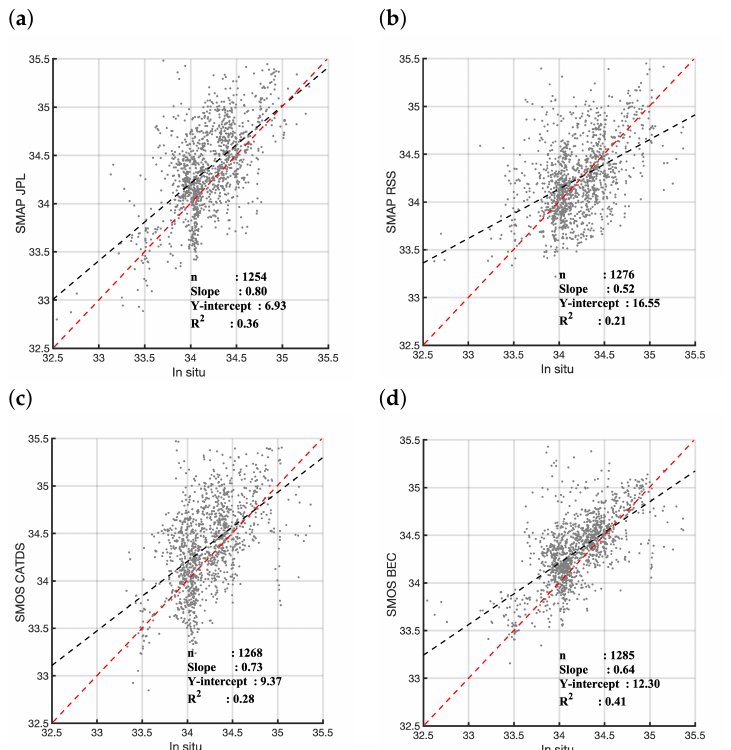
Figure 12. Scatter plots between VG2020 SSS and satellite SSS data for ( a ) SMAP JPL, ( b ) SMAP RSS, ( c ) SMOS CATDS, ( d ) SMOS BEC. The number of match-up pairs (n), slope, y − intercept and R2 coefficients of the linear fit are indicated in each plot.